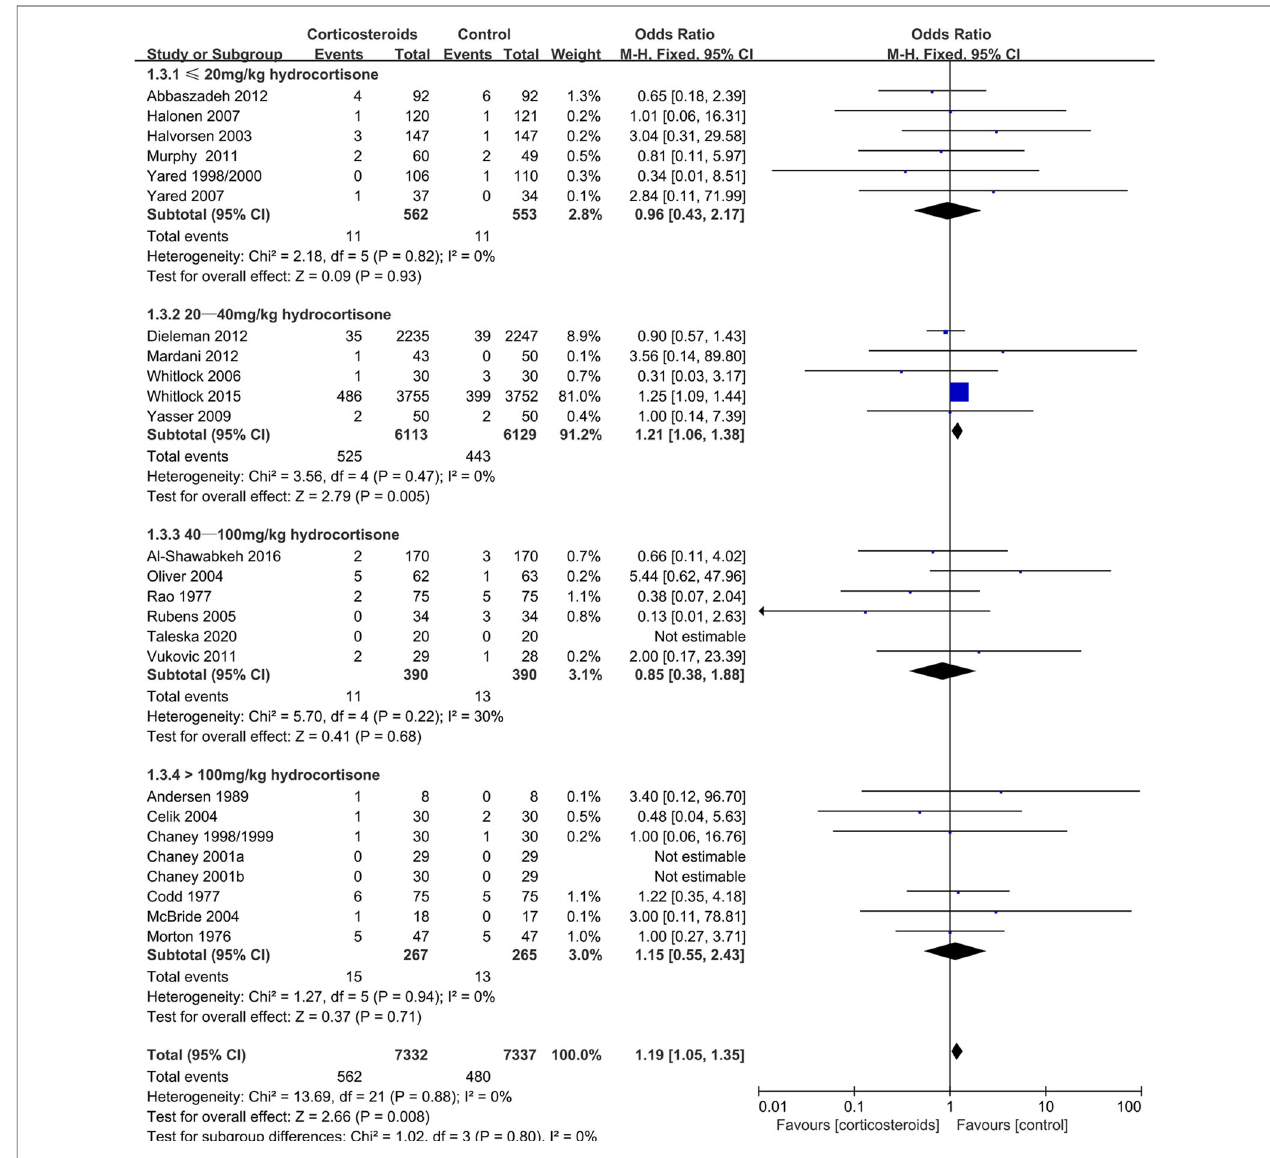
FIGURE 2 | Impact of corticosteroids on myocardial infarction